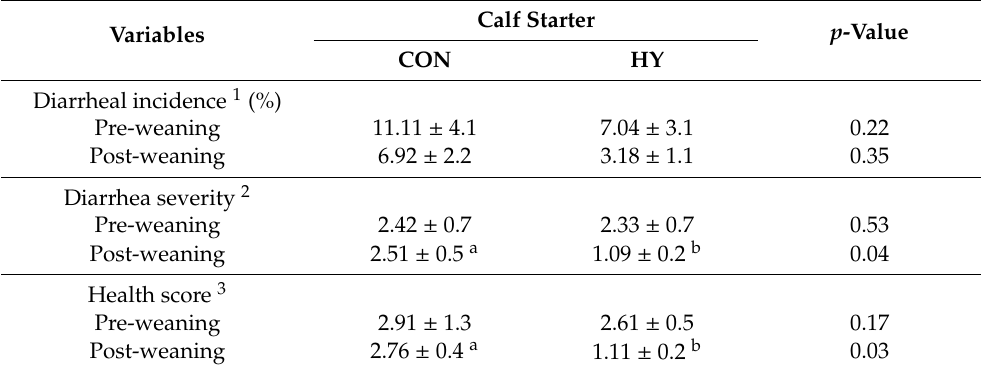
Table 3. Diarrhea incidence, diarrhea severity, and health status of the calves fed the CON and HY calf starters before and after weaning (mean ± SE).